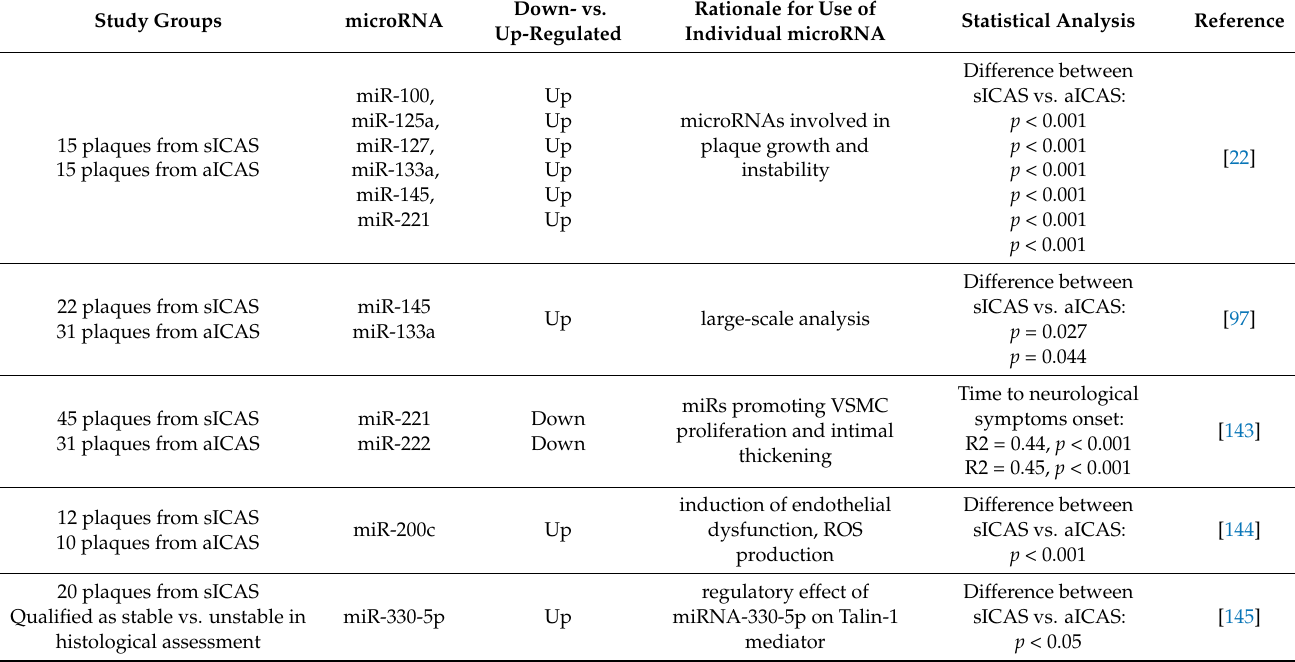
Table 3. Intra-plaque microRNAs associated with carotid plaque vulnerability and